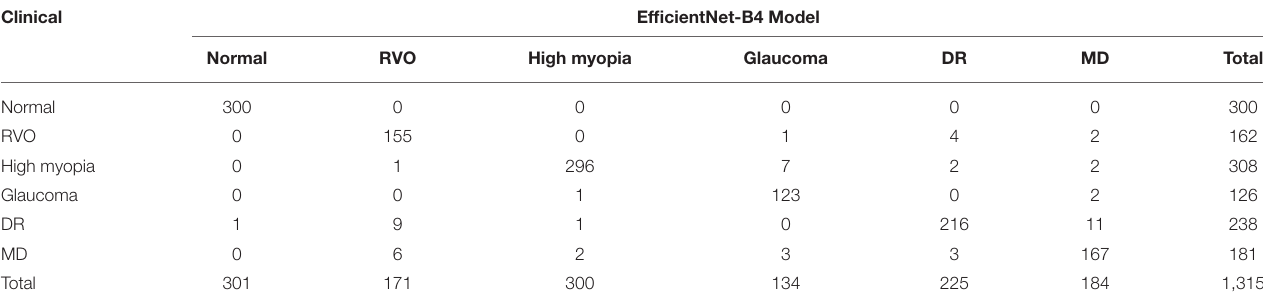
TABLE 1 | Diagnostic results of the EfficientNet-B4 model. Clinical